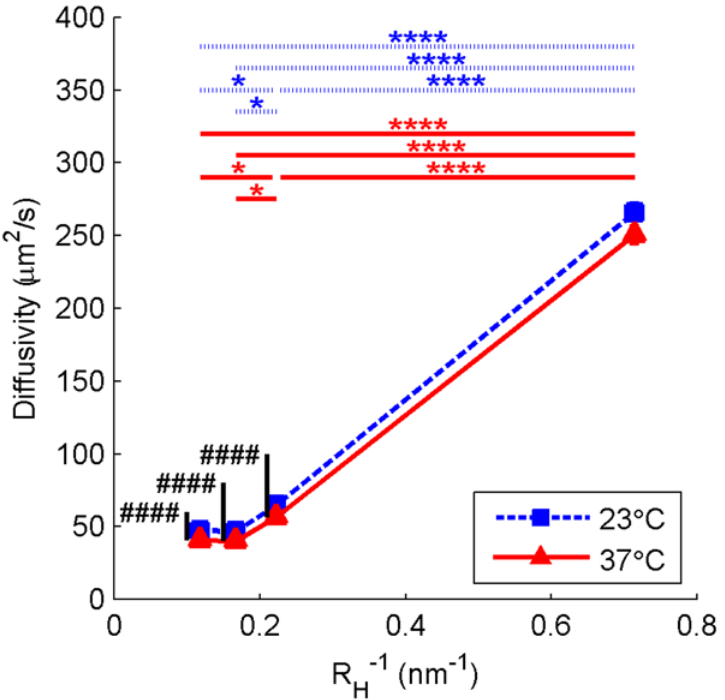
Fig 9. Rate of diffusion of dextran in collagen hydrogels. Blue square symbols with dashed lines represent hydrogels polymerized at 23°C while red triangle symbols with solid lines represent hydrogels polymerized at 37°C. Data shown are mean + SE with N = 72. Each measurement is averaged over pH and concentration. Significance was calculated for pH- and concentration-averaged groups: temperature means comparison is indicated with # while hydrodynamic radius means comparison is indicated with *